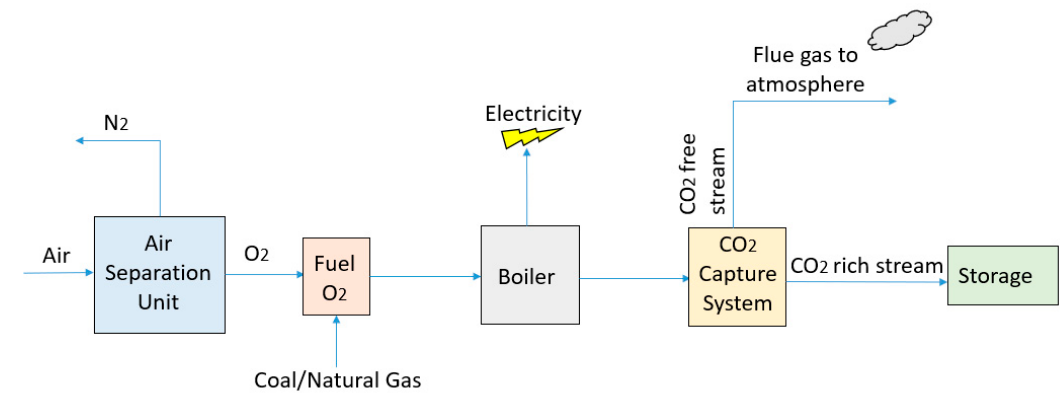
Figure 3. Block flow diagram of an oxy-fuel combustion carbon capture system.